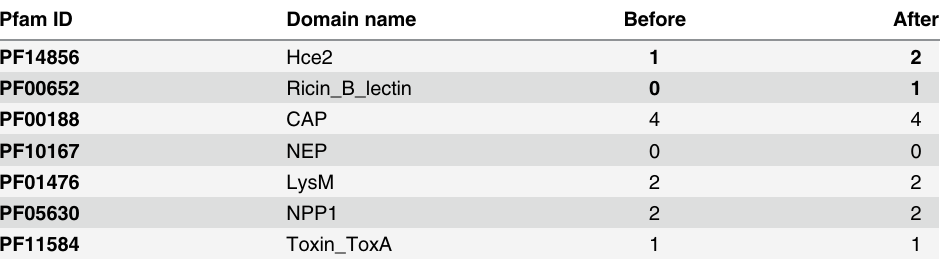
Table 7. Summary of changes to protein-products with functional annotations of high relevance to plant pathogenicity in P . nodorum SN15, before and after re-annotation.